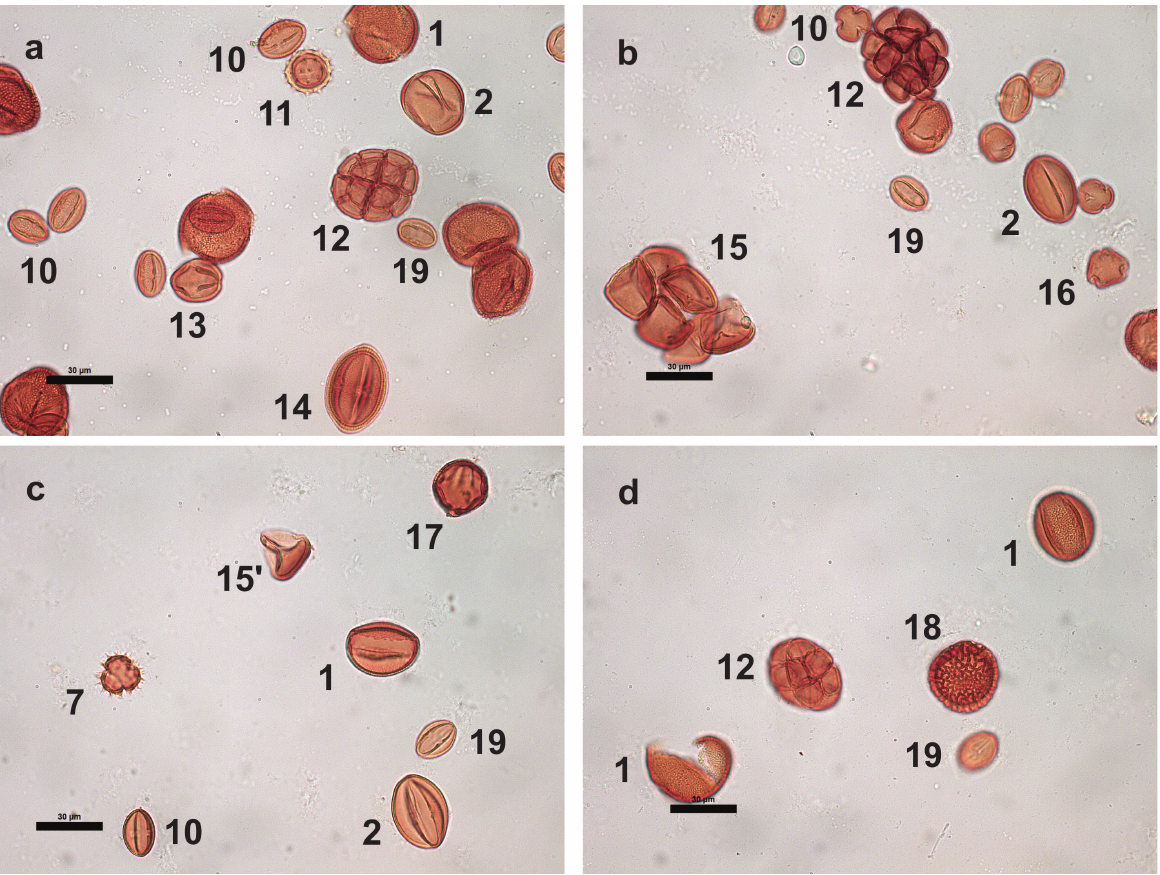
Figure 3 - Pollen types in garbage pellets of S. jujuyensis (a–d): 10_ Xylosma venosa ; 11_ Parthenium hysterophorus ; 12_type Senegalia praecox ; 13_ Geoffraea decorticans ; 14_ Holocheilus hieracioides ; 15_type Enterolobium contortisiliquum (15_a fragment of polyad and 15’_ an isolated monad); 16_ Sapindus saponaria ; 17_type Schinopsis ; 18_Bougainvillea ; 19_ Pterogyne